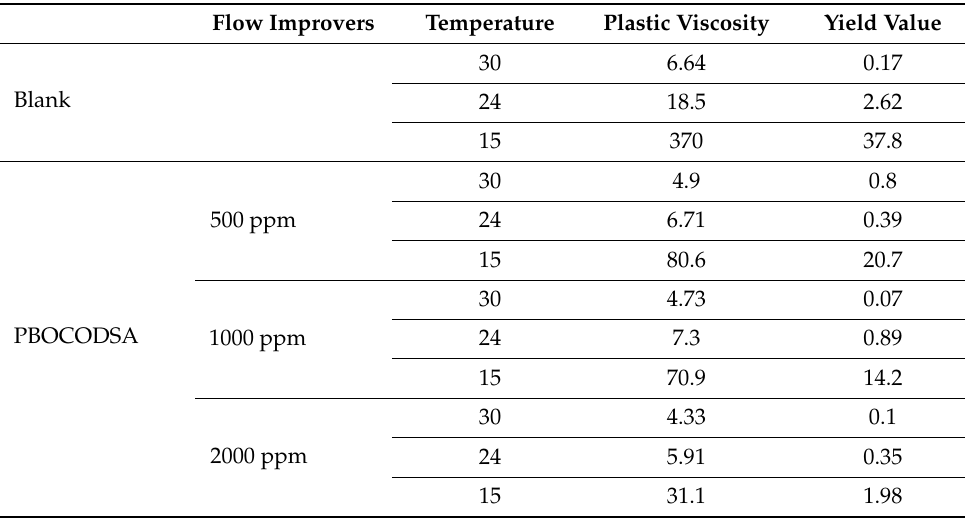
Table 3. Rheological properties of Egyptian heavy crude